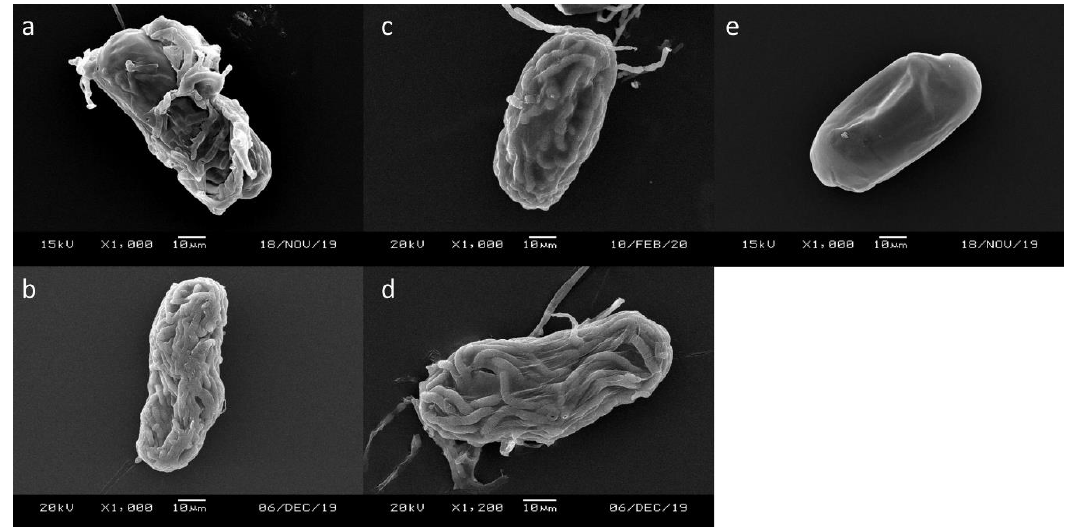
Figure 2. Observation of M. enterolobii eggs infected by nematophagous fungi through scanning electronic microscope (SEM). ( a ) Paraboeremia taiwanensis , ( b ) Samsoniella sp. strain NTUCC 18–159, ( c )